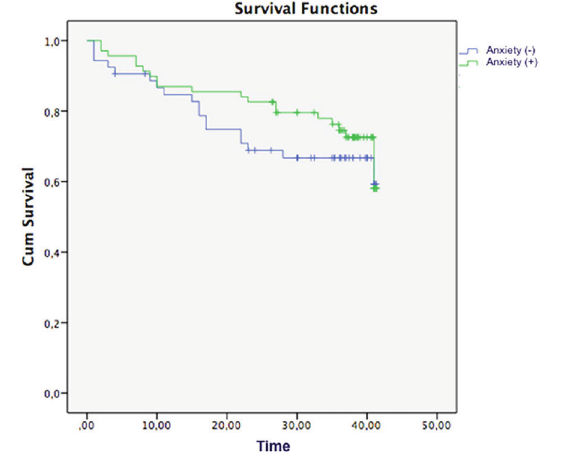
Figure 2 - KaplaMeier survival curves of the study population according to anxiety groups.